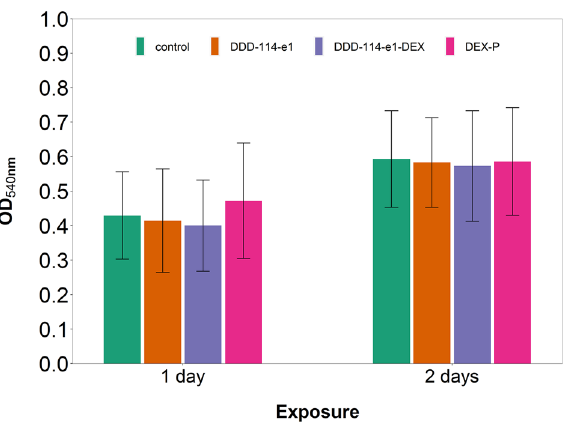
Figure 9. Mitochondrial activity of chondrocytes in cartilage explants cultured with basal media or medium containing predicted best performing PBAE